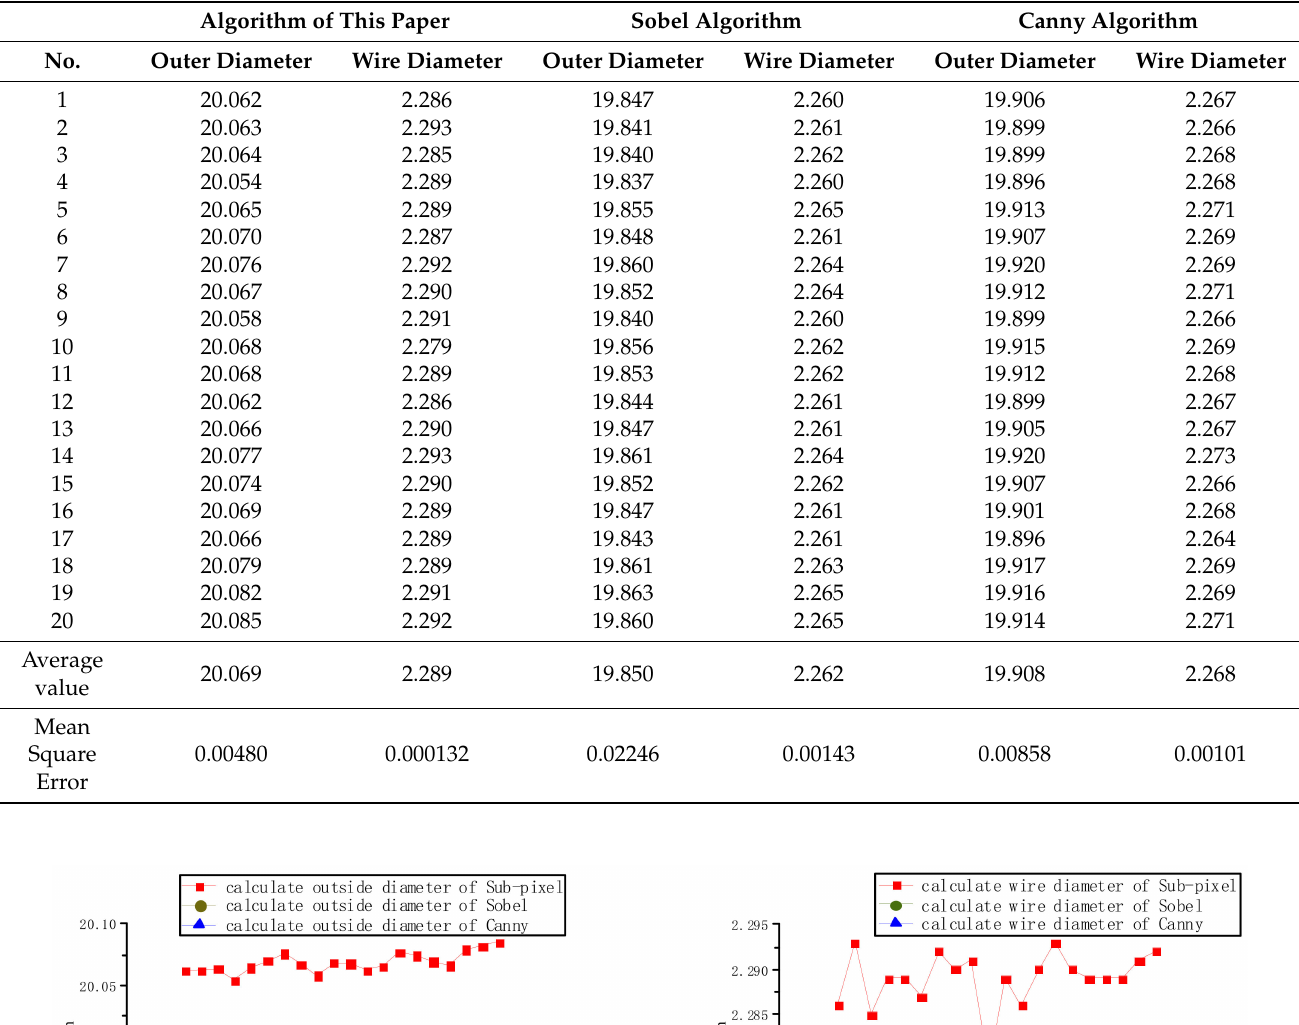
Table 2. Comparison table of measurement results of 20-mm O-ring.